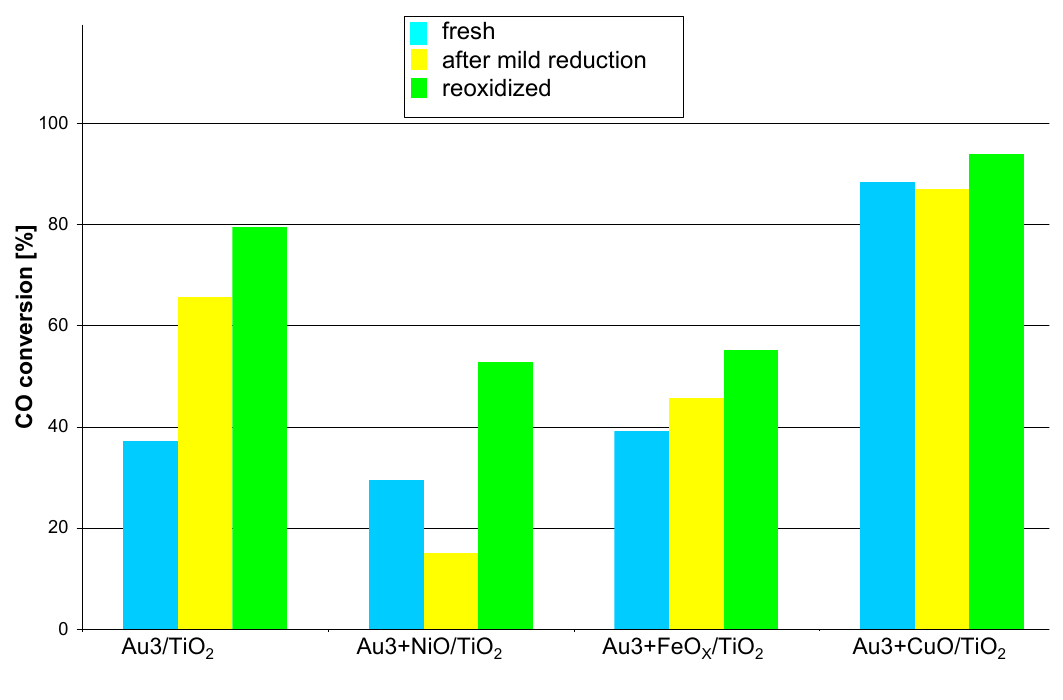
. Reaction conditions: contact 2 :He ≈ 2